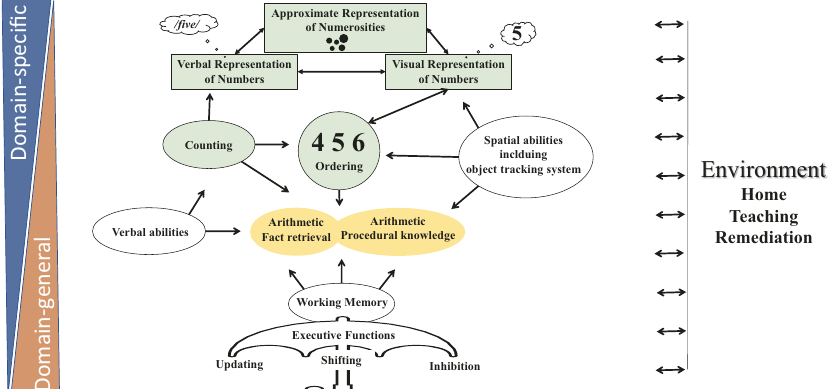
Fig. 1 Dynamic interactions of domain-speci fi c and domain-general functions that support the development of numerical (green shapes) and arithmetic abilities (yellow shapes). The approximate representation of numerosities, the verbal representation of numbers, and the visual representation of numbers build the core components of the triple-code model. Auxiliary functions such as verbal and spatial abilities are shown in white. The object-tracking system is part of rather domain-general visual – spatial abilities. Note that the classi fi cation of domain- speci fi c and domain-general is rather continuous than categorical. The arrows suggest uni- or bidirectional in fl